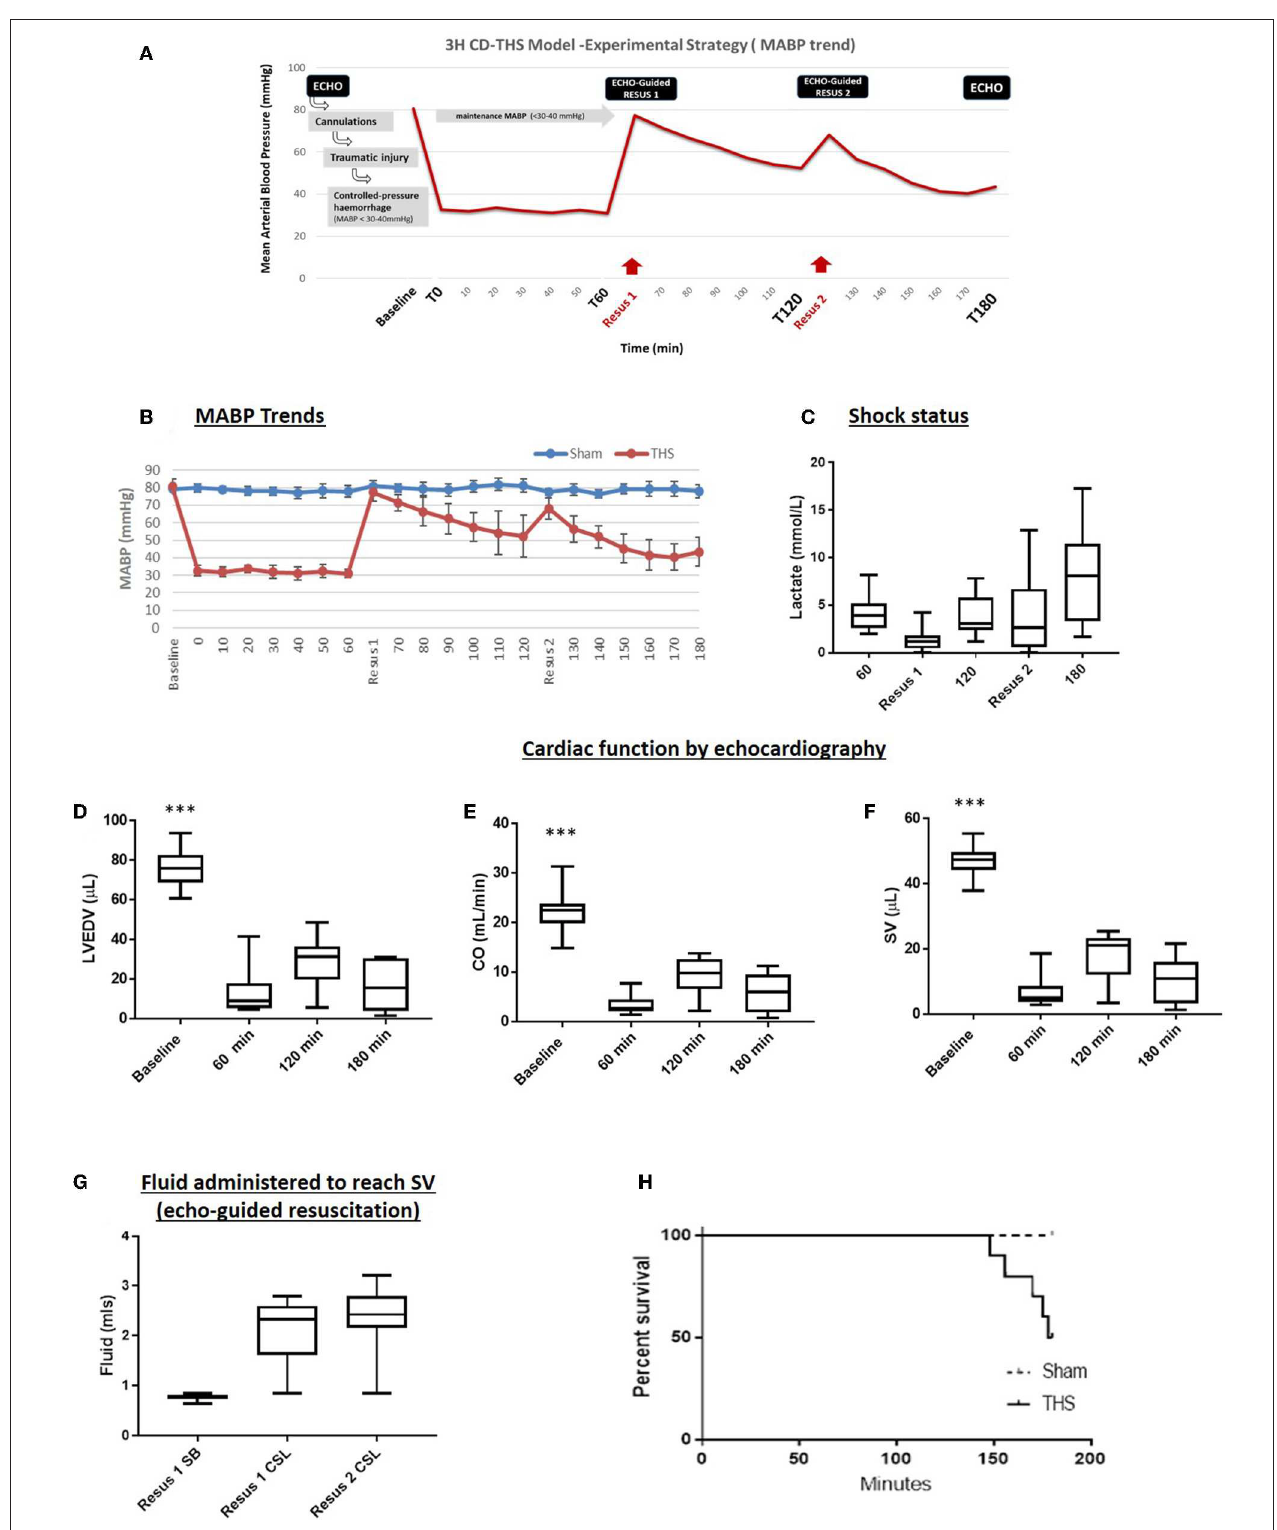
FIGURE 2 | Characterization of the 3h THS cardiac dysfunction (CD) model. (A) Modeling strategy: mice subjected to trauma hemorrhage are held at a MAP of 30–40 mmHg for an hour and then resuscitated with shed blood & crystalloid (Resus1) to their original stroke volume (SV). Mice are then left for a further hour and